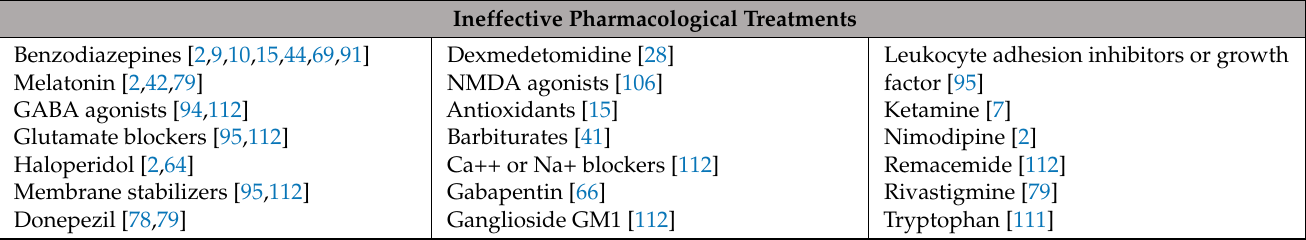
Table 5. Ineffective pharmacological methods for the treatment of postoperative delirium.